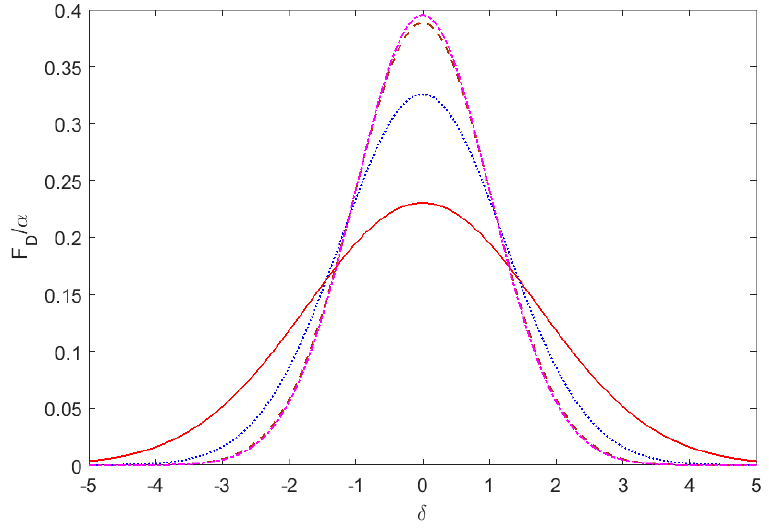
Figure 2. Absorption line shape F D ( α , δ ) / α for different values of dimensionless pulse duration; α : solid line − α = 0.5, dotted line − α = 1, dashed line − α = 3, dotted–dashed line − α = 5.